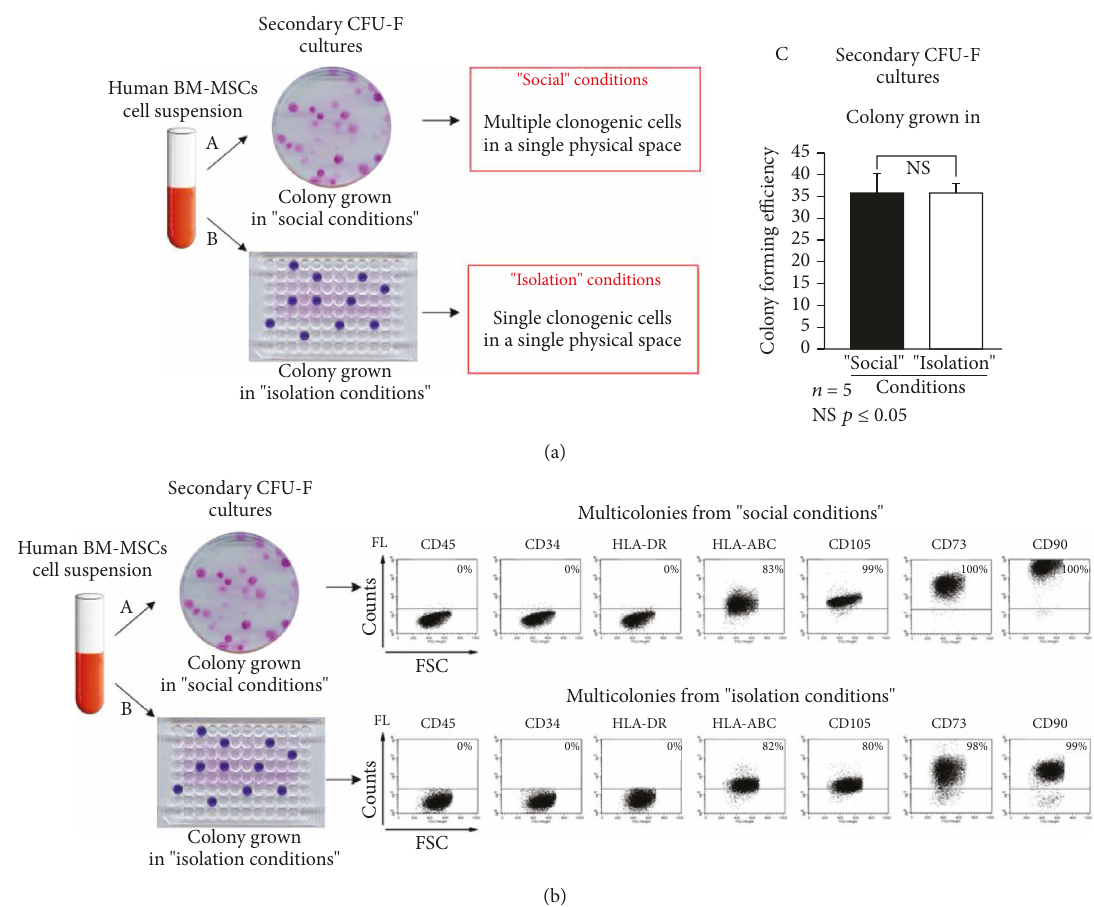
Figure 3: Social conditions on CFU-F growth. (a) To assay for secondary CFU-Fs, samples of nucleated cells from primary BM-MSC cultures were plated and cultured either in 100 mm dishes (density at 1.6 cells/cm 2 , where cells are physically isolated in a common environment: “ social conditions ” ; A) or in 96-well plates at cloning dilution (where single cells are in single wells: physical and biochemical “ isolation ” ; B) in FBS-supplemented culture medium. No di ff erences (C) were observed between numbers of BM-MSC colonies either in “ isolation ” (number of CFU-Fs) or under “ social ” conditions (number of CFU-Fs). (b) Flow cytometric analysis of a multiclonal strain obtained by combining multiple primary colonies. No signi fi cant (NS) di ff erences were observed between BM-MSCs obtained by combining multiple primary colonies from “ social conditions ” (A) or “ isolation conditions ” (B). Note the high/bright expression of multiple markers of BM-derived CFU-Fs (and “ mesenchymal stem cells ” ), CD73, CD90, and CD105 and low expression of HLA-ABC. Endothelial (CD34) and hematopoietic markers (CD45, HLA-DR) are negative. Results are expressed as the mean ± SD ( n = 5 ). ∗ p ≤ 0 05 . Results are derived from 5 independent experiments and from 3 di ff erent donors. FL: Fluorochrome; FSC: Forward